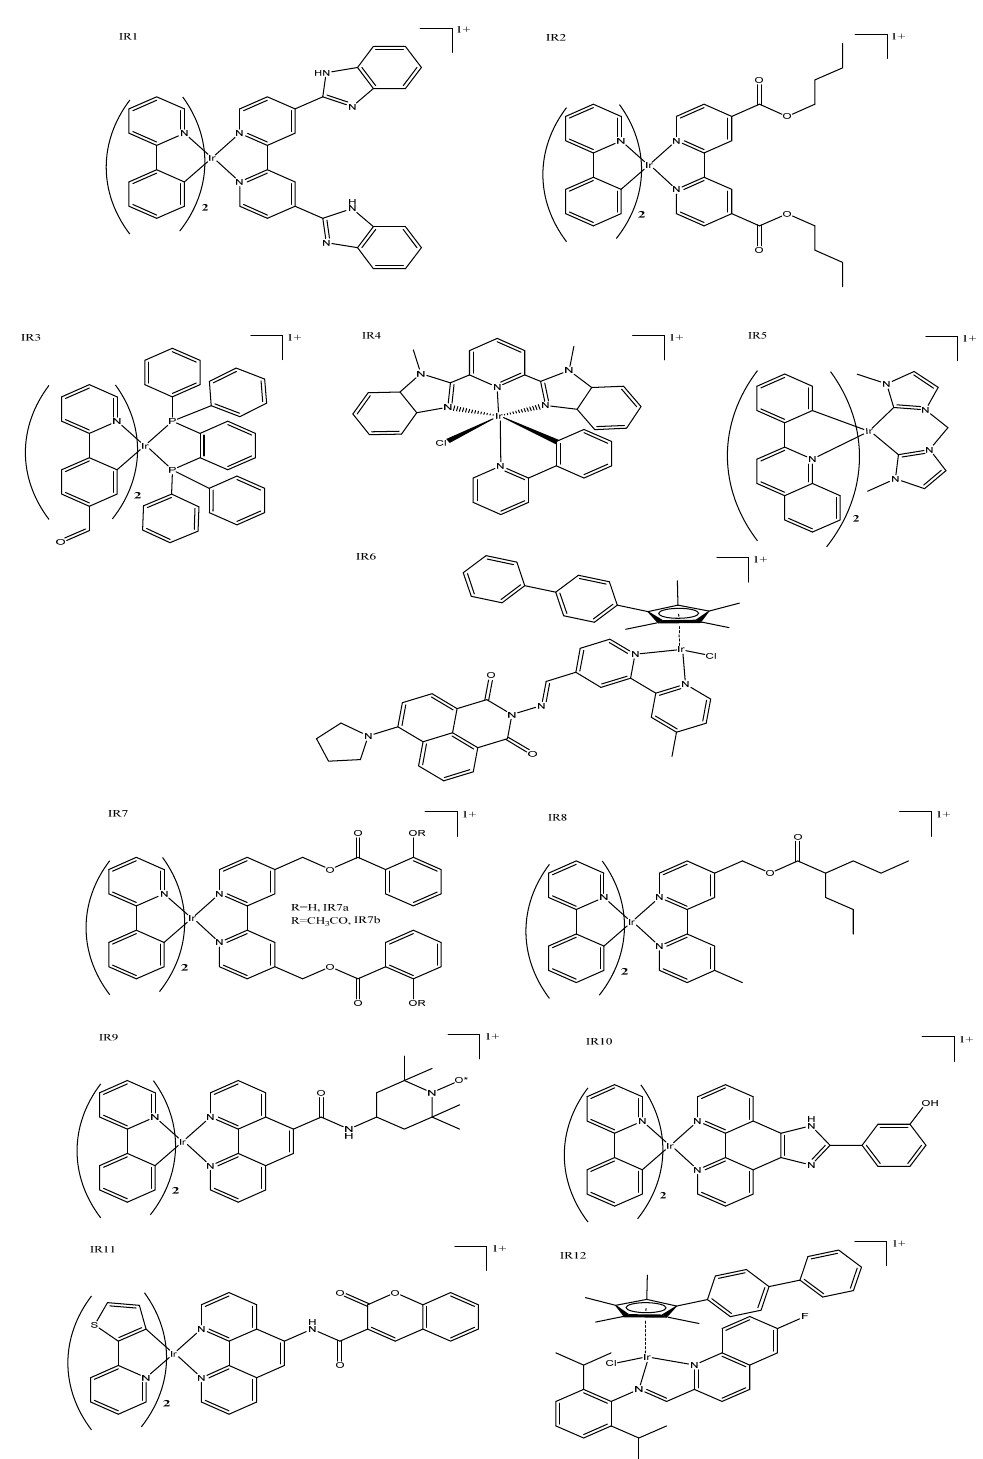
Figure 2. Mitochondria-targeting iridium complexes: cyclometallated complexes IR1 [18], IR2 [19], IR3 [20], IR5 [22], IR7a (where R = H (aspirin)), IR7b (where R = CH 3 CO (salicylic acid)) [25], IR8 [26], IR9 [27], IR10 [28], and IR11 [29]; half-sandwich complexes IR6 [24] and IR12, [30]; tridentate complex IR4